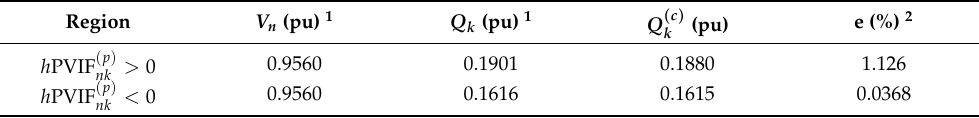
Table 6. Apparent line length equivalence between 175 and 225 km.